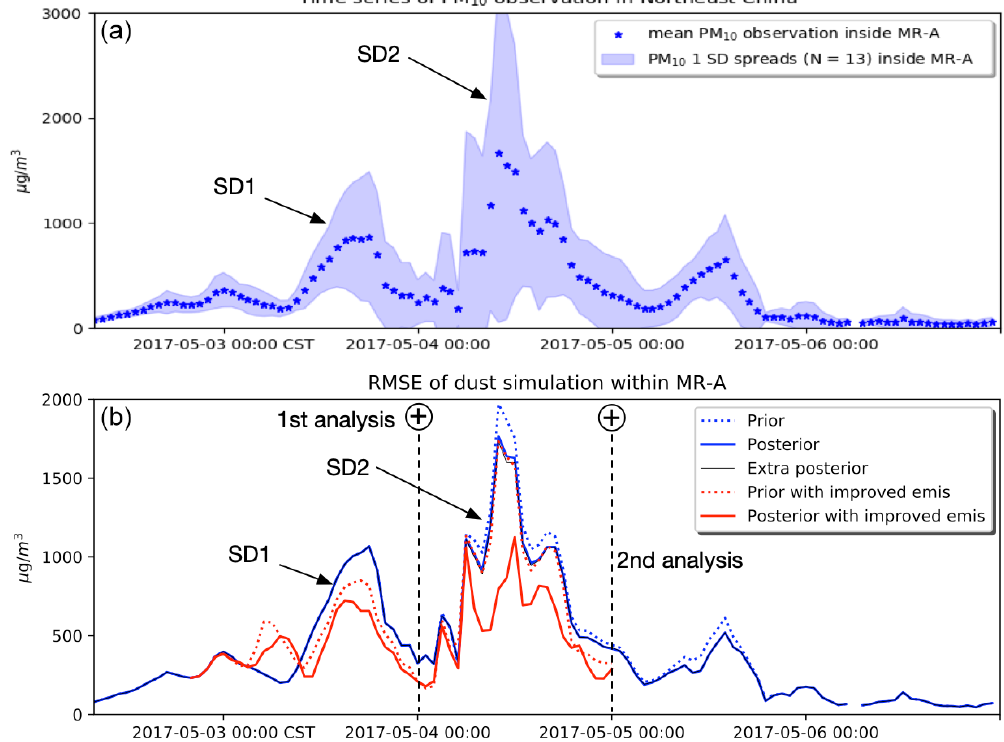
Figure 7. (a) Hourly PM 10 observations averaged over MR-A (13 sites), with shaded area indicating the standard deviation range; (b) root mean square error of prior and posterior simulation, posterior of extra emission inversion, and reconstructed prior and posterior within MR-A. The location of the stations is indicated in Fig.